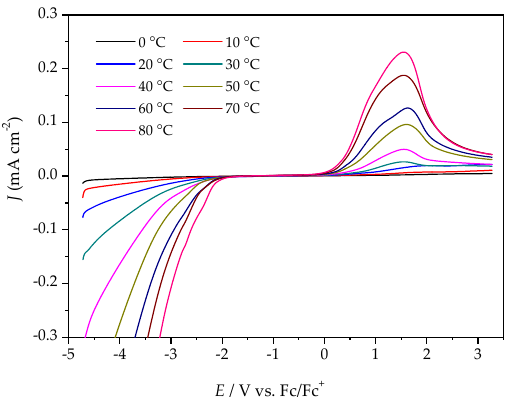
Figure 6. LSV of [P 4,4,4,8 ][BScB] at a GC electrode, different temperatures, and a scan rate of 20 mV s −1 .